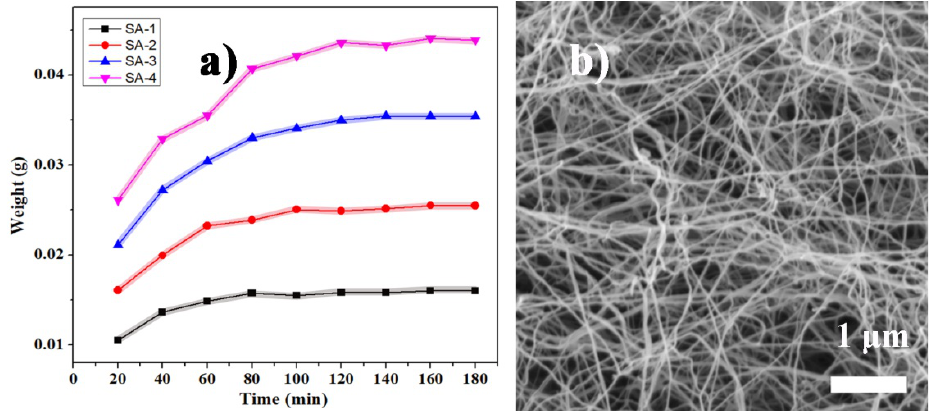
Figure 2. ( a ) The effect of soaking time in the silica alcosols (SA-1, SA-2, SA-3, and SA-4 respectively) on the weight of the dried BC wet gel sample, and ( b ) the microstructure of BC matrix.